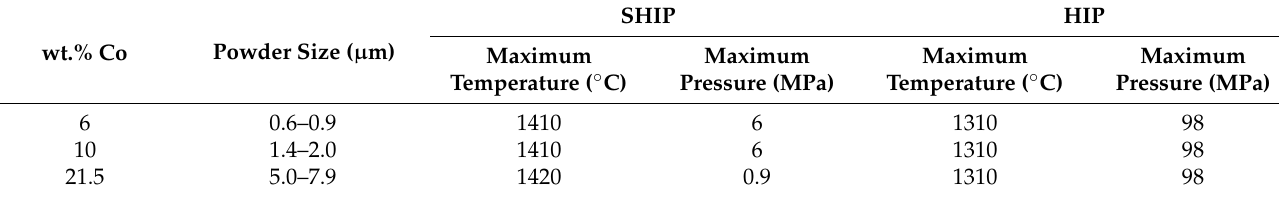
Table 2. Process conditions of SHIP and